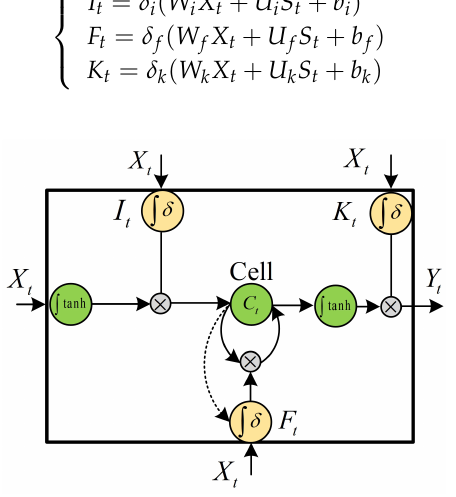
Figure 4. The internal structure of the LSTM